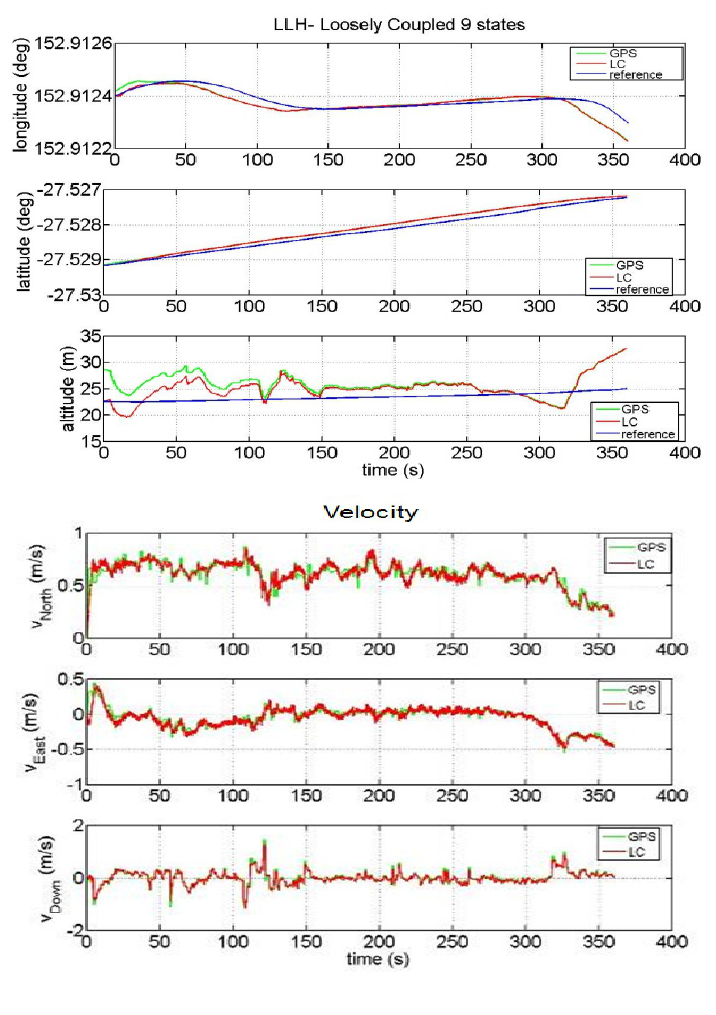
Figure 6. LC performance obtained with real data: Position (LLH), Velocity and Euler